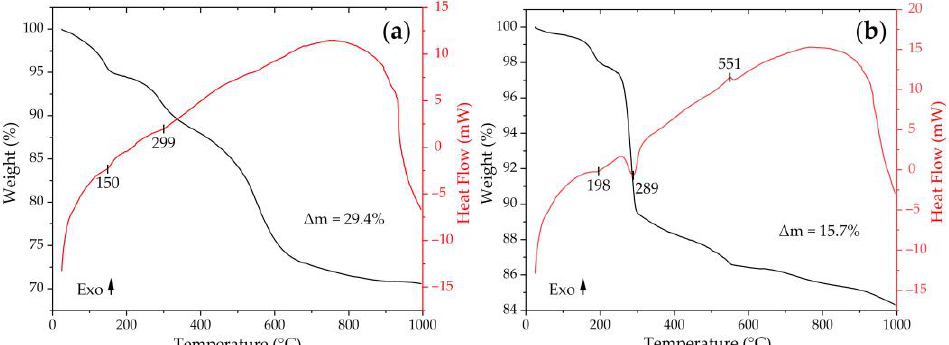
Figure 1. TGA (black) and DSC (red) curves for semiproducts obtained in the hydrothermal synthesis of (CeO 2 ) 0.8 (Sm 2 O 3 ) 0.2 oxide ( a ) and after applying the nickel oxide shell on its surface ( b ).